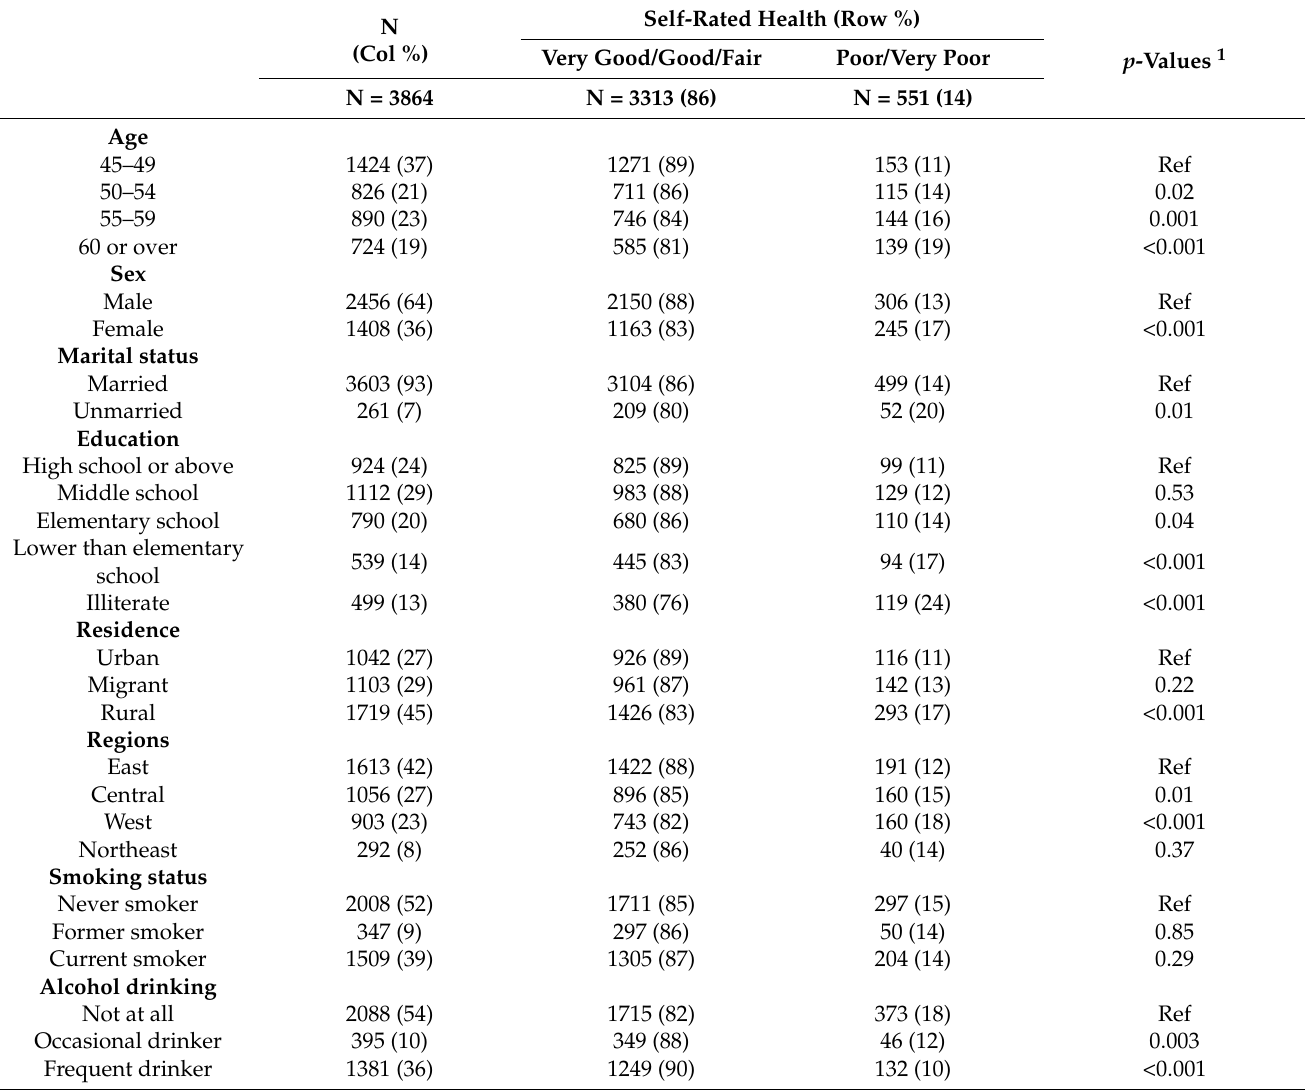
Self-Rated Health (Row %)